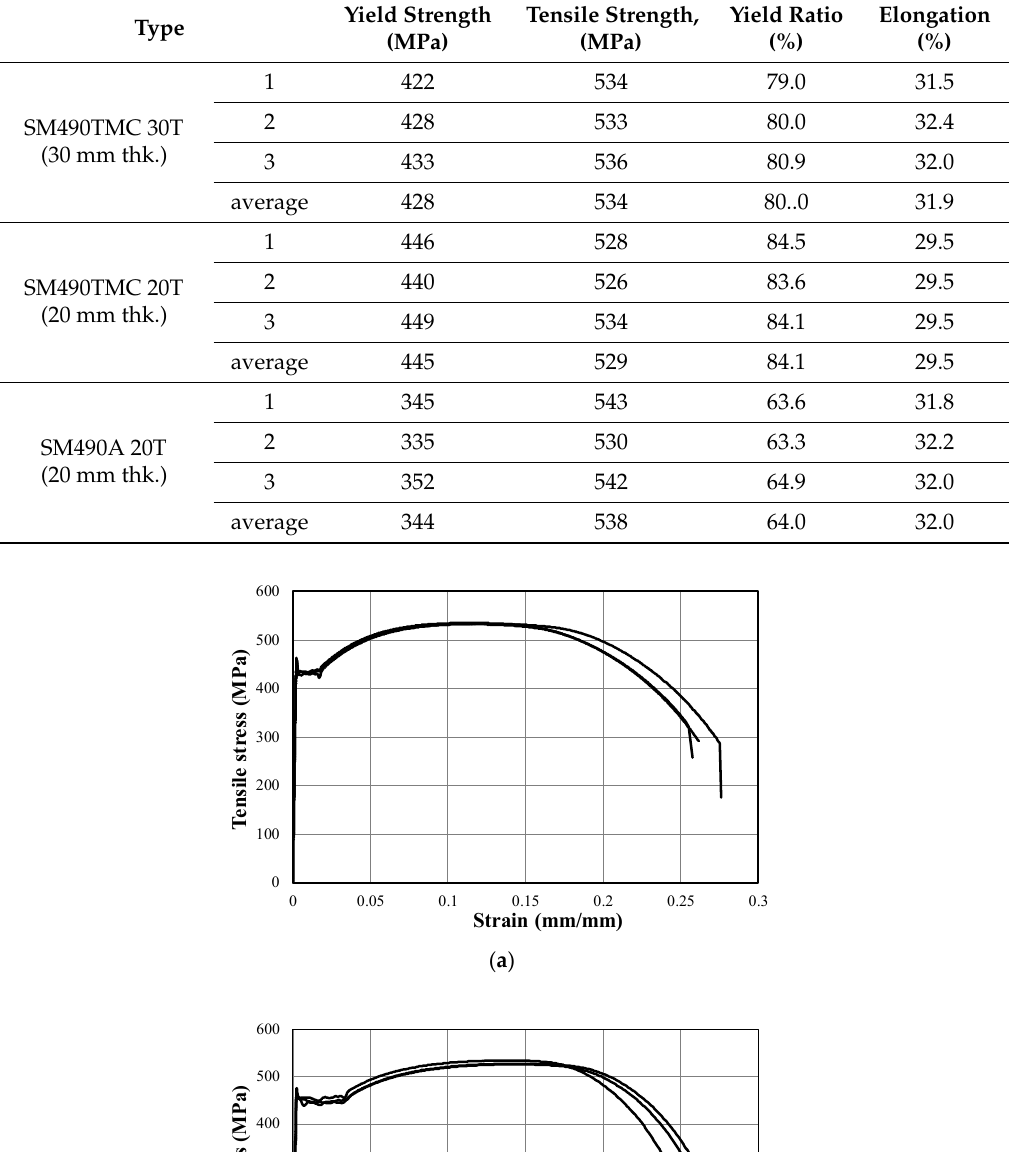
Table 2. Tensile test result.